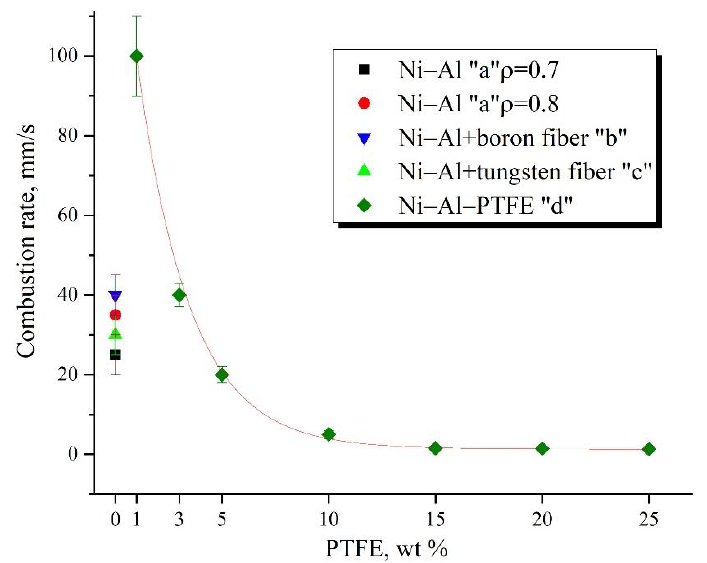
Figure 13. Combustion rates for different types of specimens.